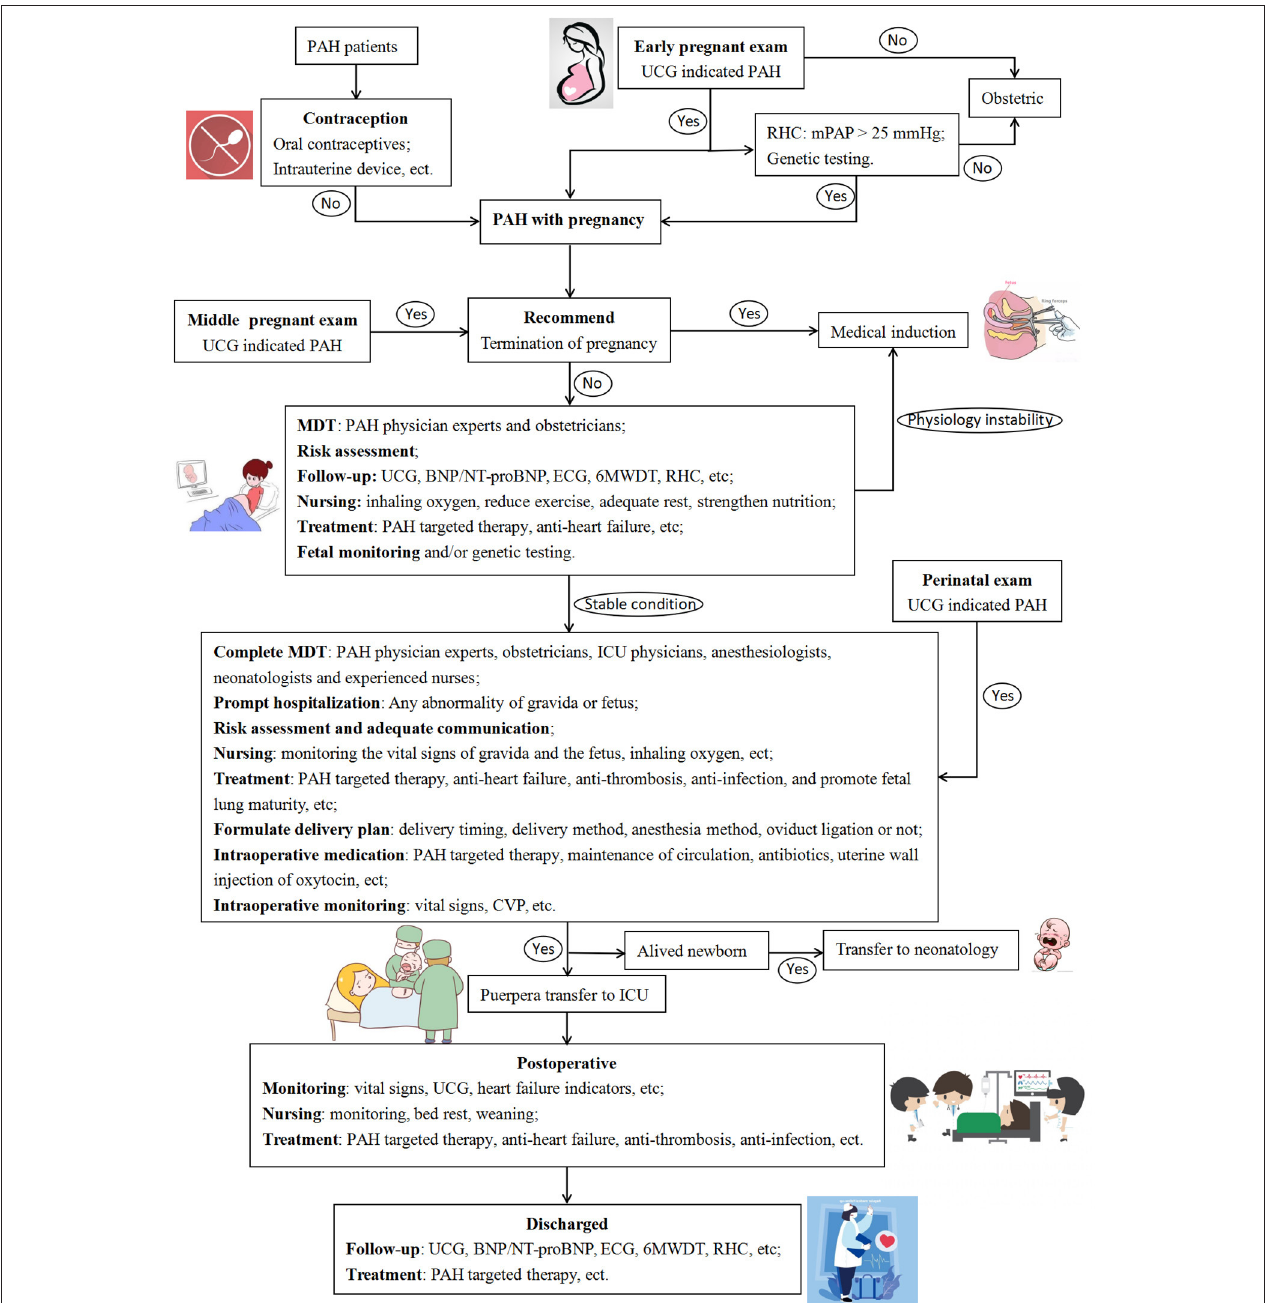
FIGURE 2 | Flow chart of diagnosis and treatment for pregnant PAH patients. PAH, pulmonary arterial hypertension; UCG, ultrasound cardiogram; RHC, right heart catheter; mPAP, mean pulmonary artery pressure; MDT, multidisciplinary team; BNP, B-type natriuretic peptide; NT-proBNP, N terminal pro B-type natriuretic peptide; ECG, electrocardiogram; 6MWDT, six minutes walking distance test; ICU, intensive care unit; CVP, central venous